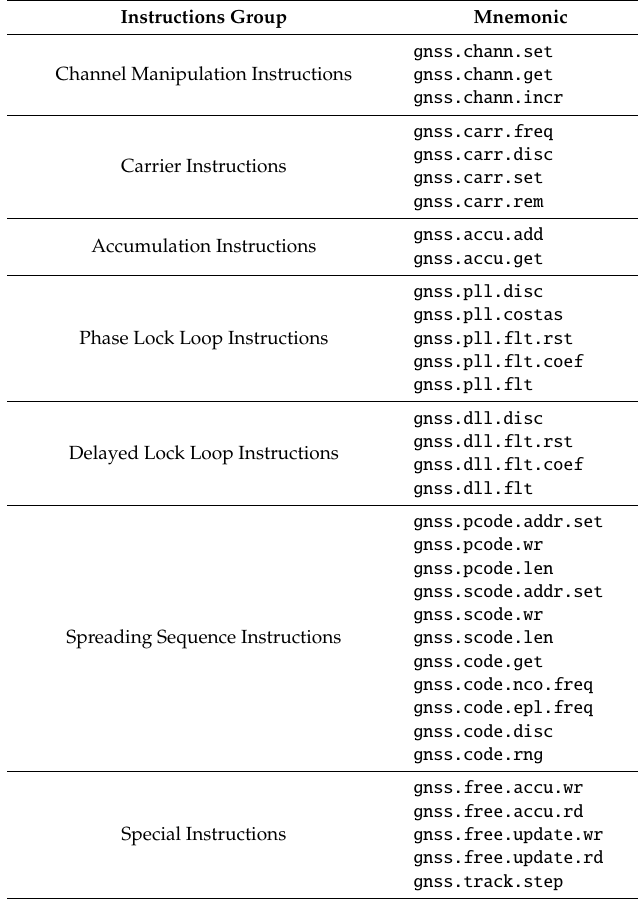
Table 1. Summary of introduced Global Navigation Satellite System-instruction set extension (GNSS-ISE)